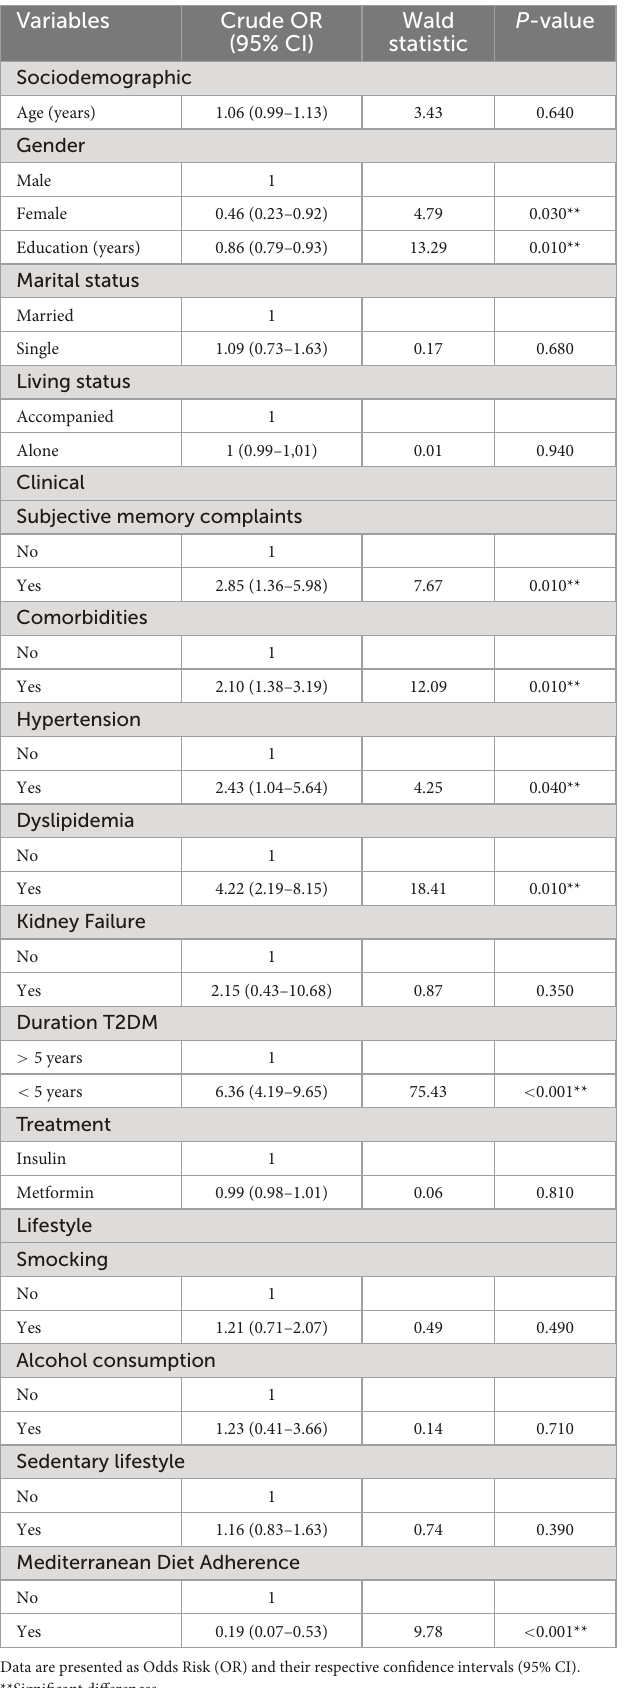
TABLE 5 Multivariate logistic regression analysis of associations between Type 2 Diabetes Mellitus with Cognitive Impairment participants and sociodemographic, clinical, and lifestyle